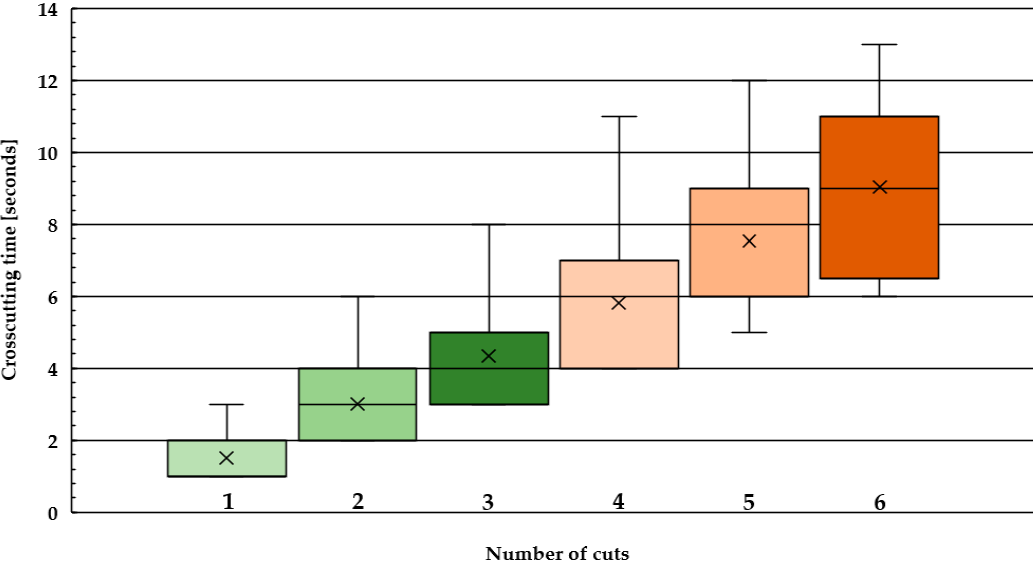
Figure 3. Variation of cumulated crosscutting time as a function of the number of crosscuts. Legend: × stands for the mean value. Note: outliers not included in the figure.